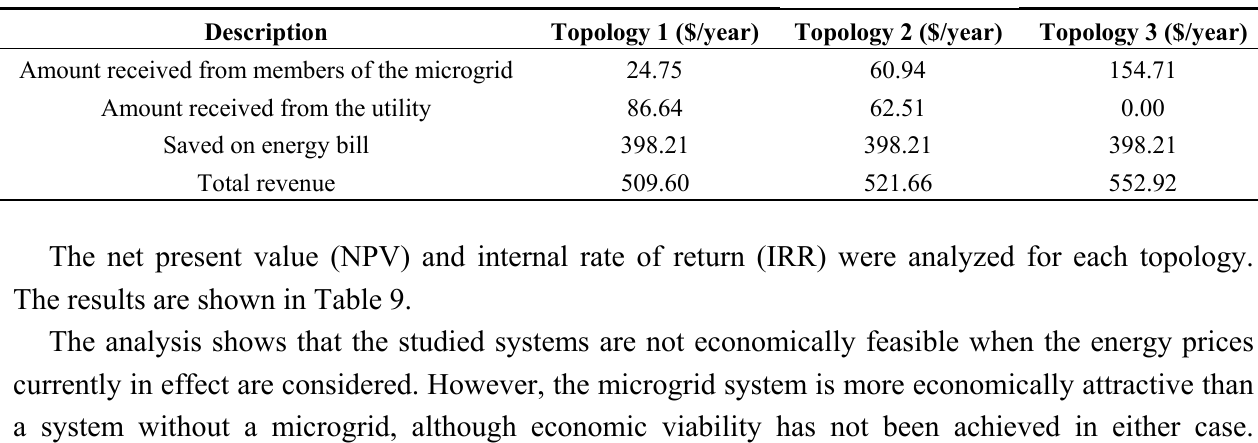
Table 8. Average annual values received by each owner of a generation